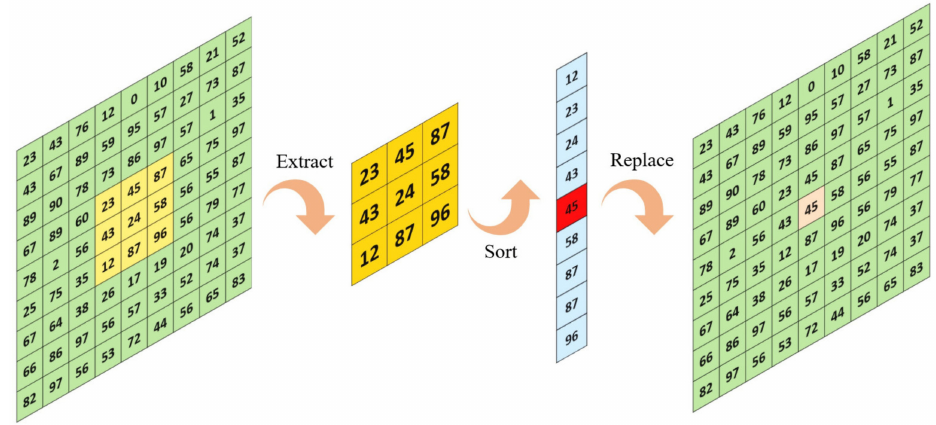
Figure 2. Median